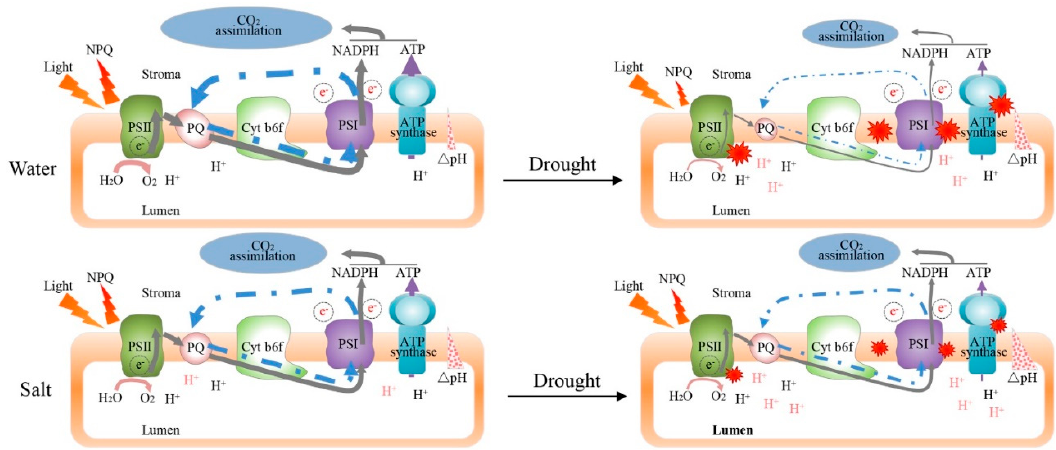
Figure 6. Schematic presentation of the photosynthetic response mechanism of soil salinity-induced cross-tolerance to drought stress in tomato plants. Soil salinity pretreatment can enhance CO 2 assimilation efficiency and the activity of PSI and PSII compared with water controls when plants suffer subsequent drought stress. Soil salinity can induce PSI non-photochemical energy dissipation owing to the donor-side limitation and regulated energy dissipation in PSII, but can reduce PSI non-photochemical energy dissipation owing to both the donor and accept-side limitation. Moreover, soil salinity can maintain higher NPQ at PSII, thereby protecting PSI and PSII in tomato plants from the damage caused by subsequent drought stress. Soil salinity significantly reduces the rate of both linear and cyclic electron transport while alleviating the decrease of ETR(II), ETR(I), and CEF in tomato leaves exposed to subsequent drought stress; the maintenance of CEF may serve as an important acclamation mechanism to protect PSI from the damages caused by subsequent drought stress. The soil salinity treatment had the capacity to decrease the rate of lumen-to-stroma proton transfer via ATP-synthase, which induces a greater acidification in the thylakoid lumen so that it can induce photoprotection through NPQ upon plant exposure to subsequent drought stress.